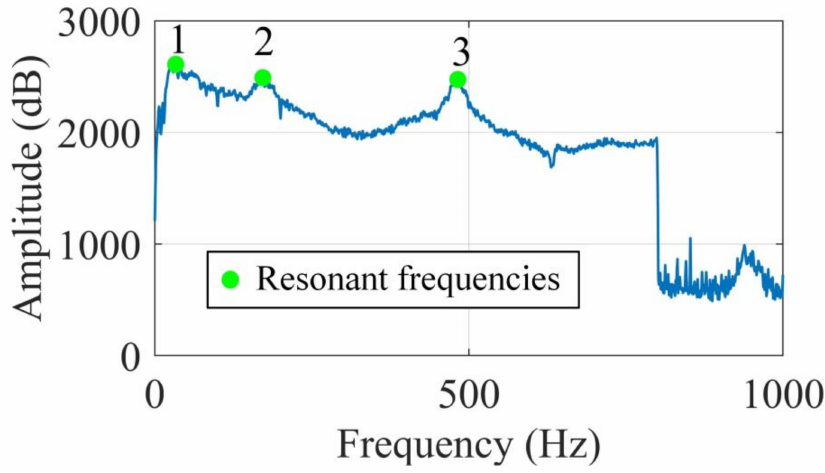
Figure 9. System natural frequency indicator based on the SVD of the PSDT